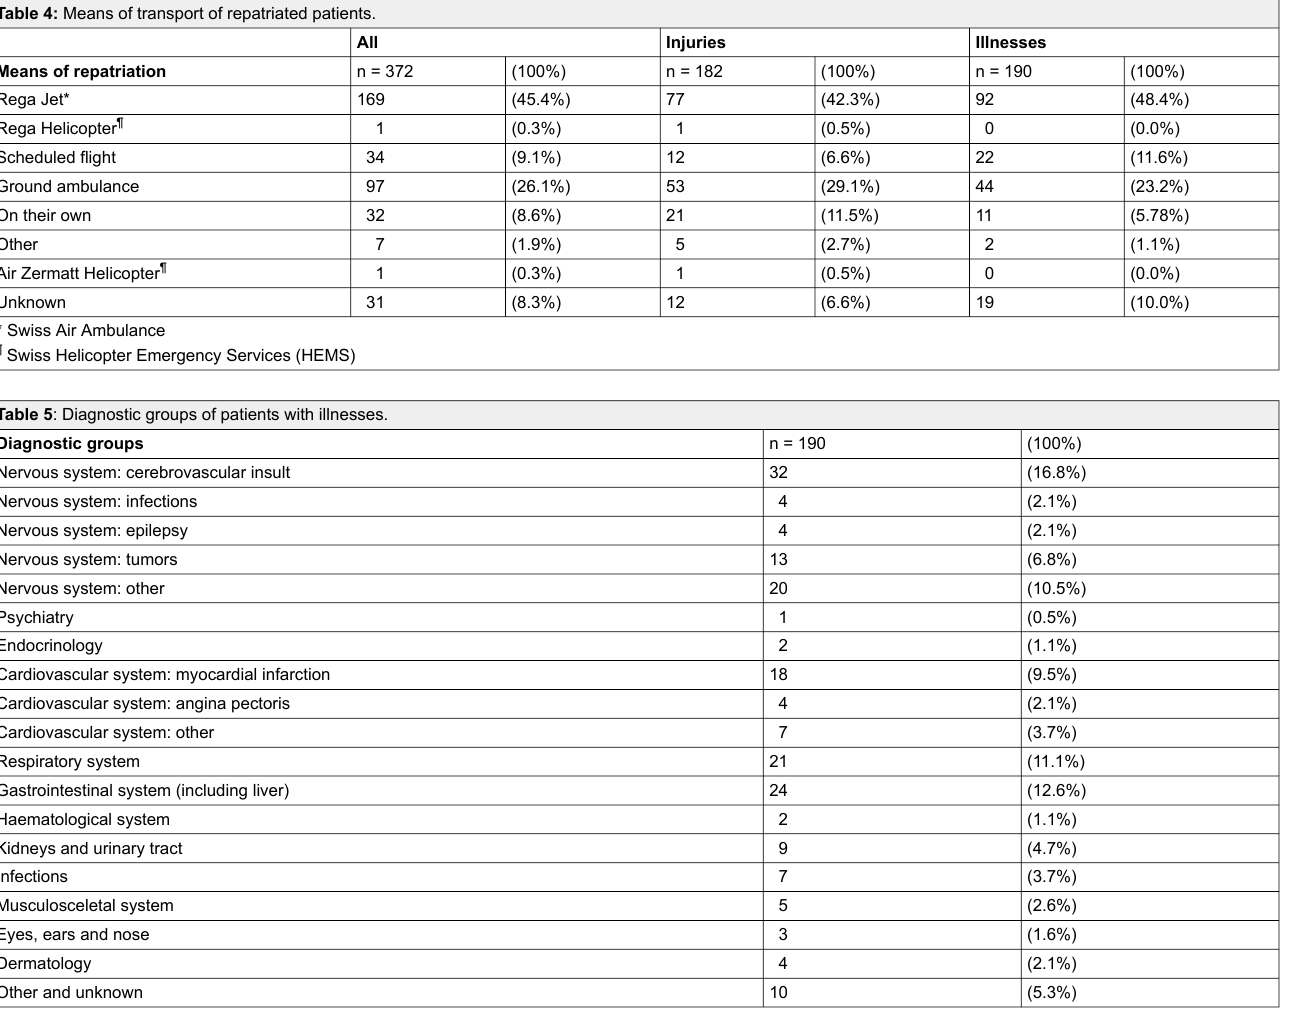
Table 4: Means of transport of repatriated patients.